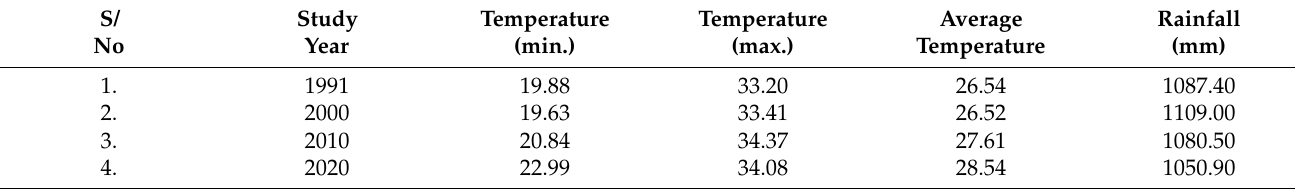
Table A1. Annual Mean Temperature ( ◦ C) and Rainfall (mm) Data for the study periods.